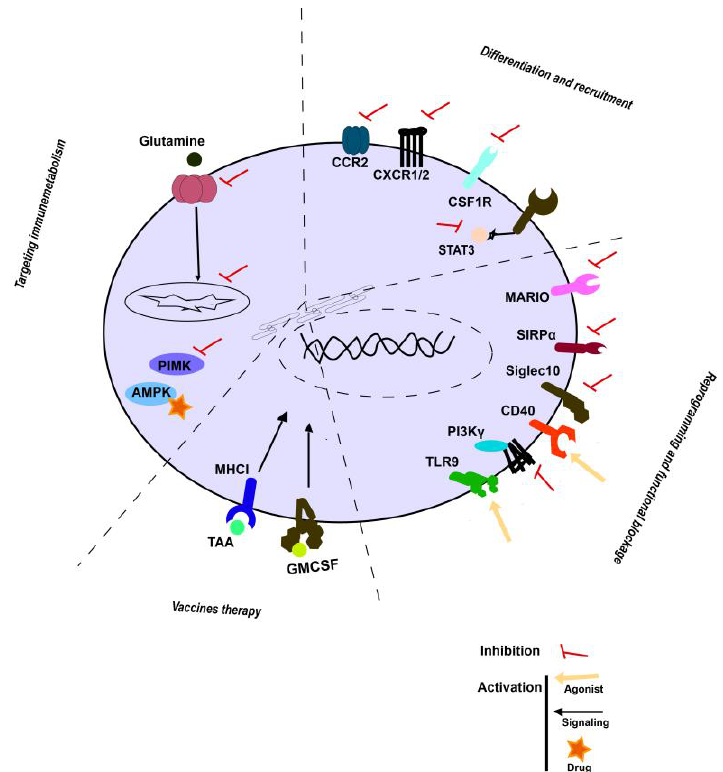
Figure 2. Emerging strategies in targeting TAMCs. Schematic representation of main strategies described above.